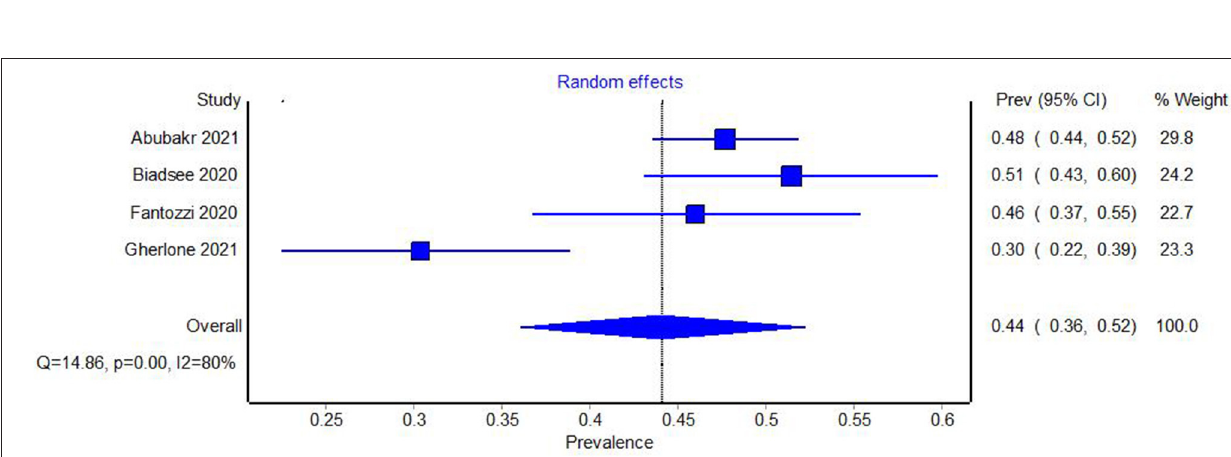
FIGURE 3 | Forest plot showing the pooled prevalence of xerostomia in